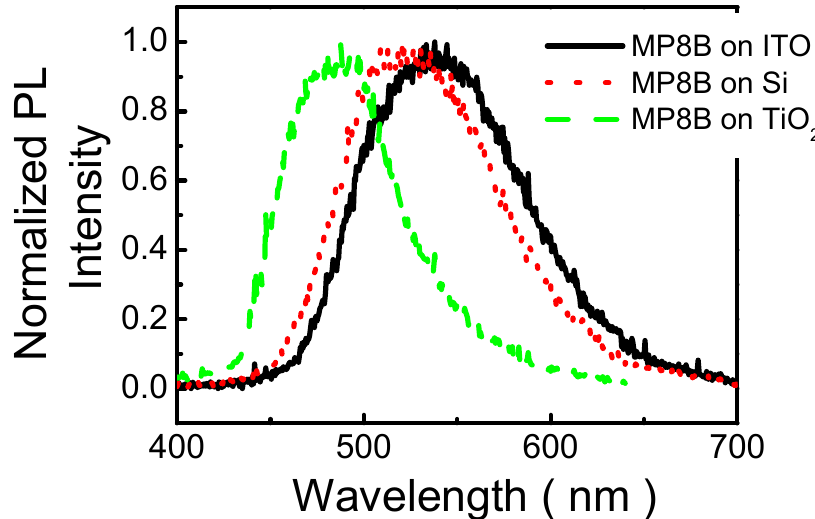
solution concentration, the larger the size of the self-assembled nanoparticle, so that MP8B film is rougher at higher concentrations.